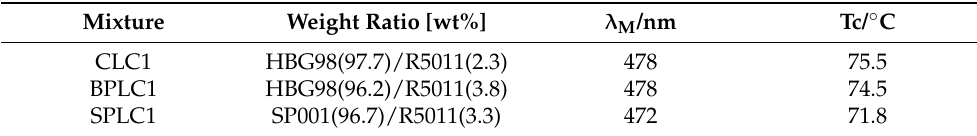
Table 2. Compositions, reflection central wavelengths, and clearing points of CLC1, BPLC1 and SPLC1.